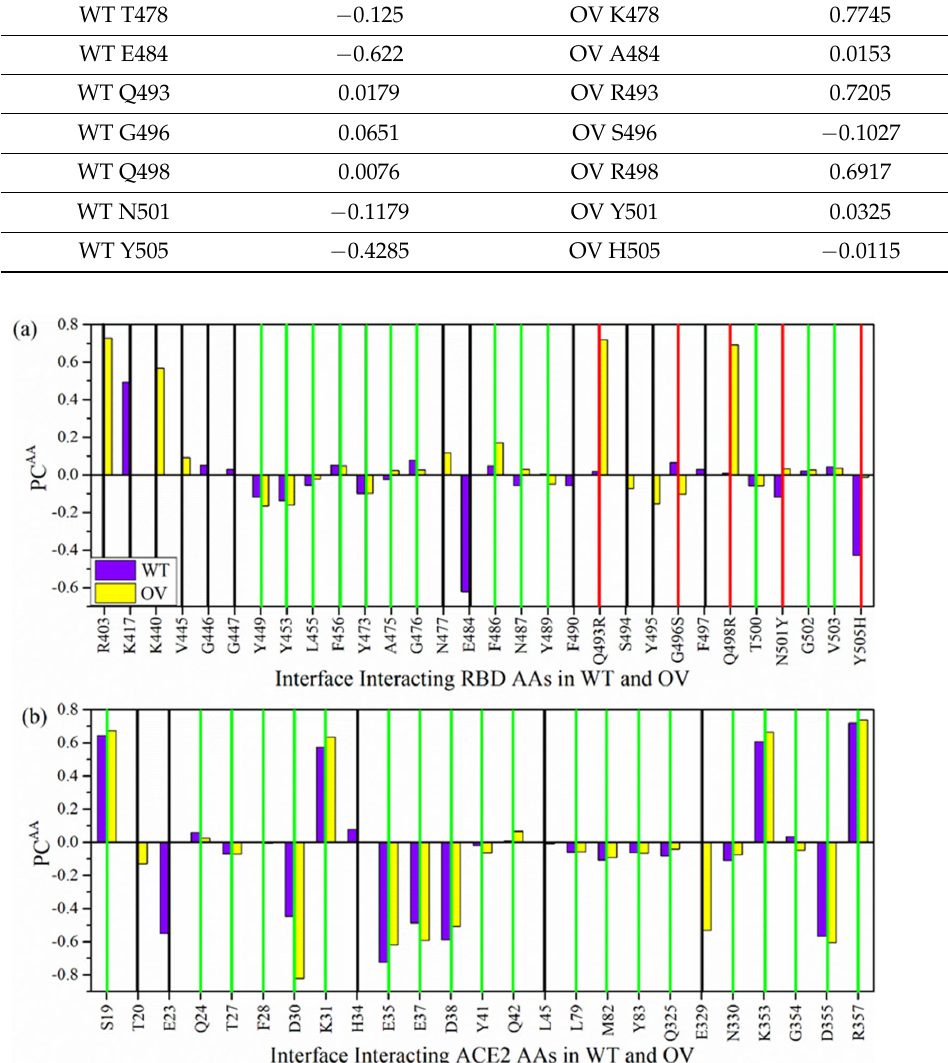
Figure 10. Bar graph for the PC AA of each interacting AA in the interface region of ( a ) RBD and ( b ) ACE2 for the WT and OV model. The vertical red lines in ( a ) denote the mutated AAs in RBD. The vertical green lines denote common interface interacting AAs in both WT and OV. The vertical black lines denote AAs that are interface interacting either in WT or in OV.